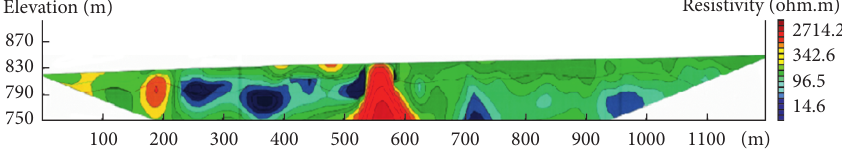
Figure 22: Test line of GMD05.